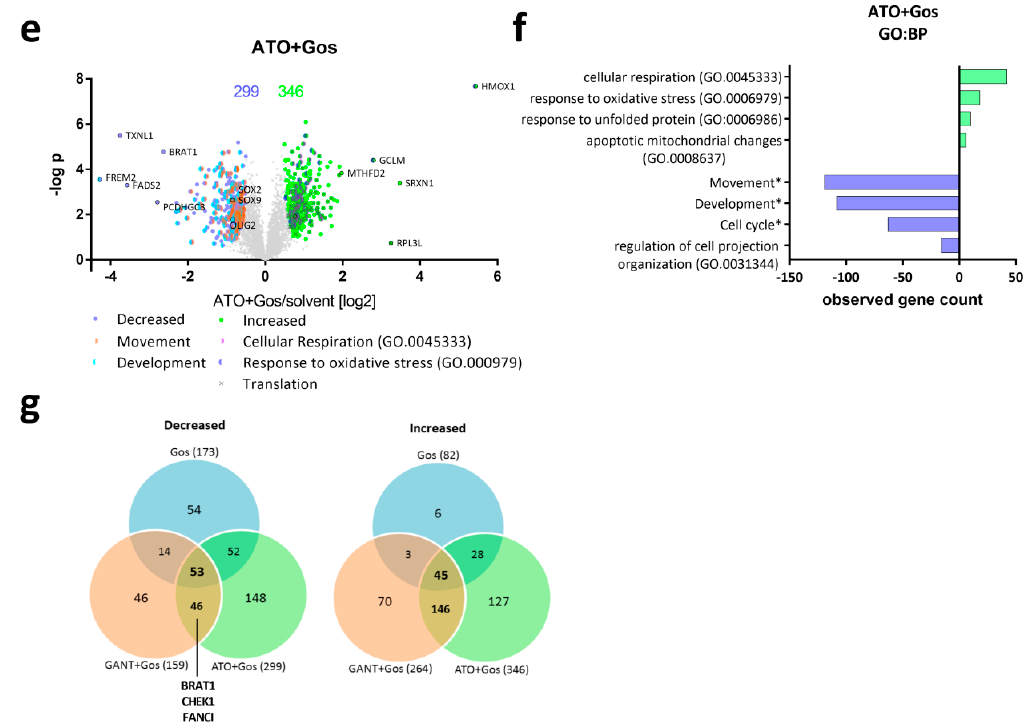
Figure 2. GANT and ATO-treatment in combination with Gos causes global proteomic changes affecting differentiation, cell cycle and proliferation. ( a , c , e ) Volcano Plots showing the protein ratios (in log2) as a function of the –log p-values of label-free quantification proteomics data of GS-5 after treatment for 24 h with ( a ) 5 µ M Gos alone or in combination with ( c ) 2.5 µ M GANT or ( e ) 2.5 µ M ATO. 5008 proteins were quantified, the amount of significantly changed proteins is written above the Plot. ( b , d , f ) Bar Chart after bioinformatic analysis using the STRING-platform (string-db.com, [26]) and Revigo (revigo.irb.hr, [27]) for enriched Gene Ontology biological processes (GO:BP) and manual clustering (marked with an *) after treatment with ( b ) Gos alone, ( d ) GANT + Gos or ( f ) ATO + Gos. ( g ) Venn diagram depicting the overlap between the significantly (left side) decreased and (right side) increased proteins. Note that the x-axis in ( b , d , f ) depicts the number of proteins that are significantly decreased (negative values) and increased (positive values).